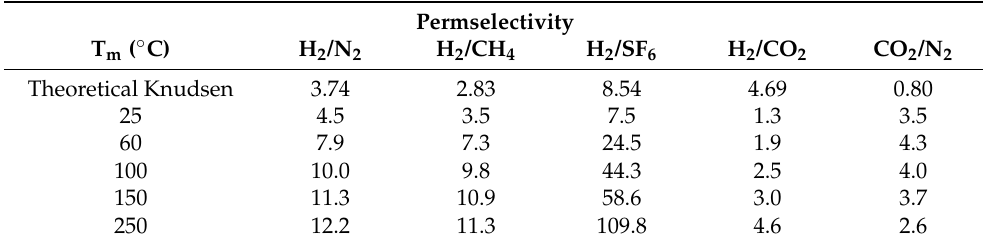
Table 1. Permselectivity values of HybSi ® membrane M-A for various gas pairs, compared to the theoretical Knudsen values.